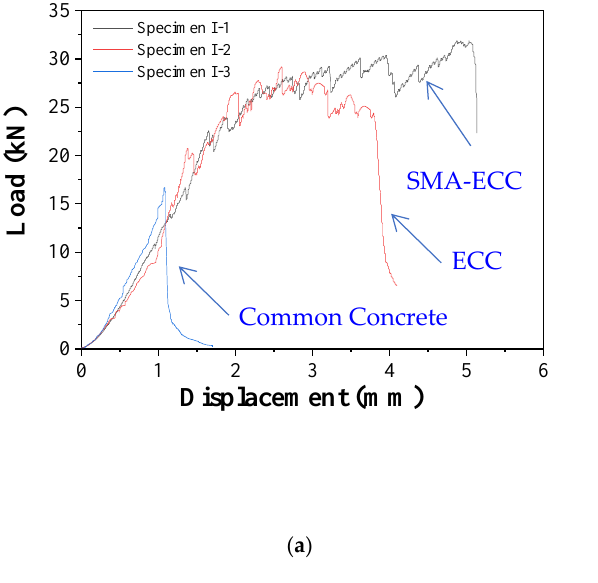
Figure 1. The stress-strain curves and crack comparison of SMA-ECC. ( a ) The stress -strain curves of SMA-ECC specimen under uni-axial tension [13]. ( b ) Cracks comparison of SMA-ECC beam before and after self-healing [14].